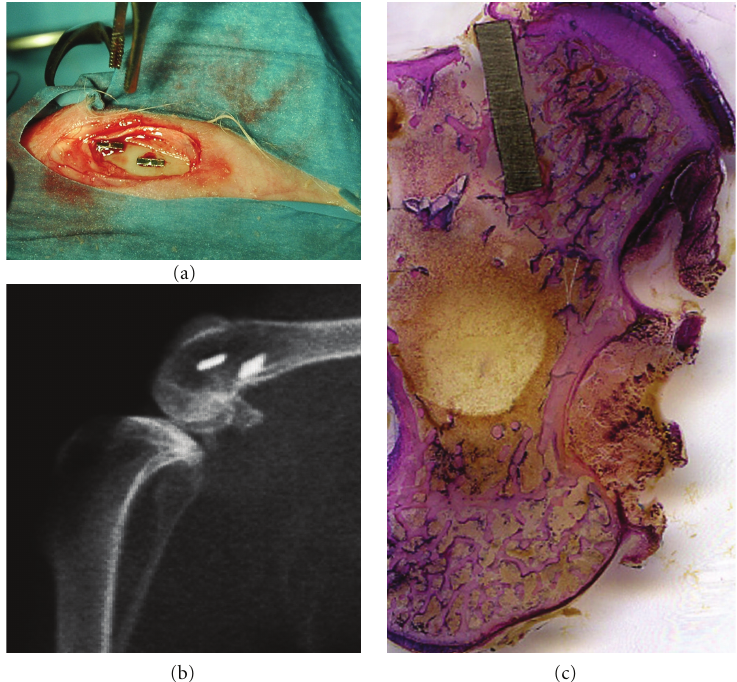
Figure 2: Clinical view of the device placement in rabbit proximal tibial epiphysis (a). X-ray micrograph of the surgical site (b). Histological ground section of an implant device. The implant is medially and laterally surrounded by cortical and trabecular host bone. LM, toluidine blue, and acid fuchsin staining,